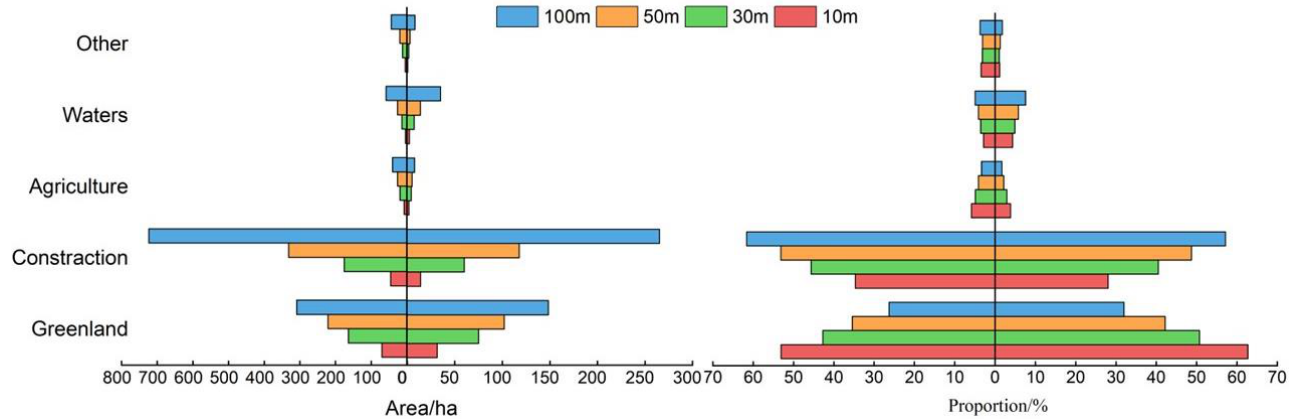
Figure 9. Changes in land use in buffer zones at different distance from potential corridors.